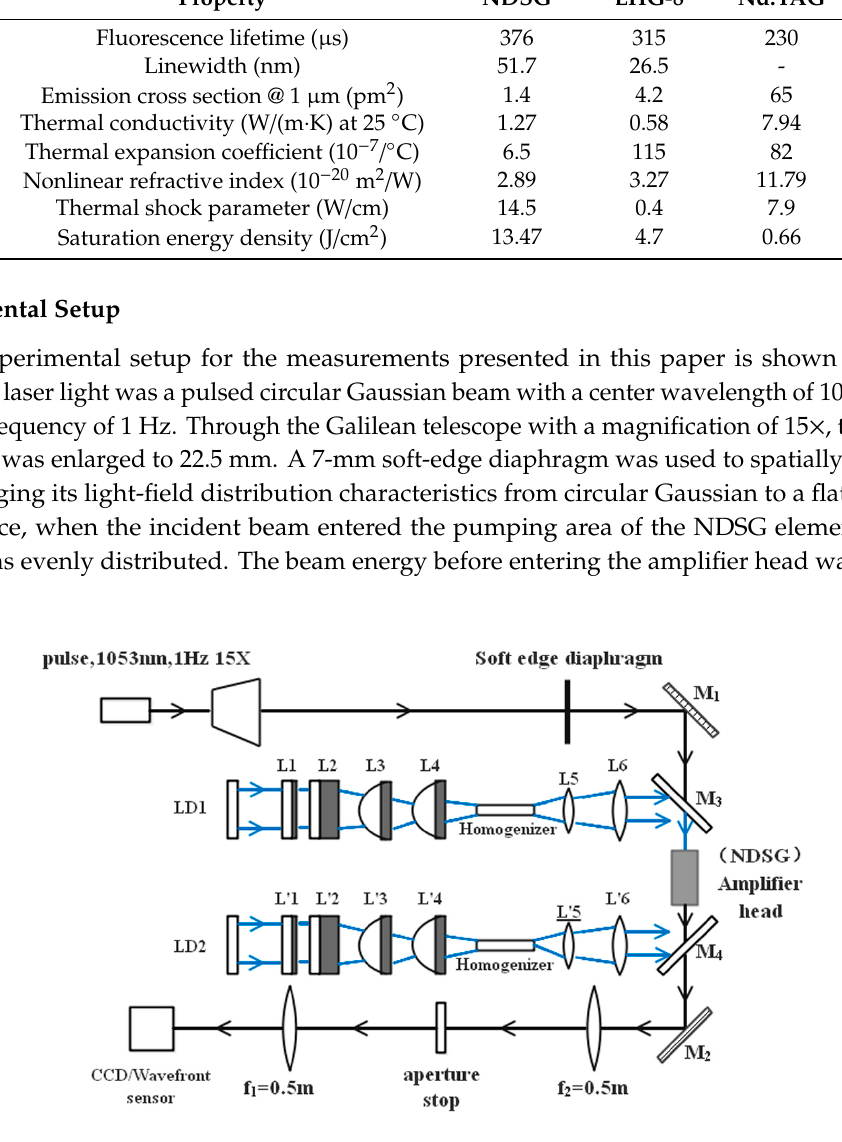
Table 1. Physical parameters of three gain materials.